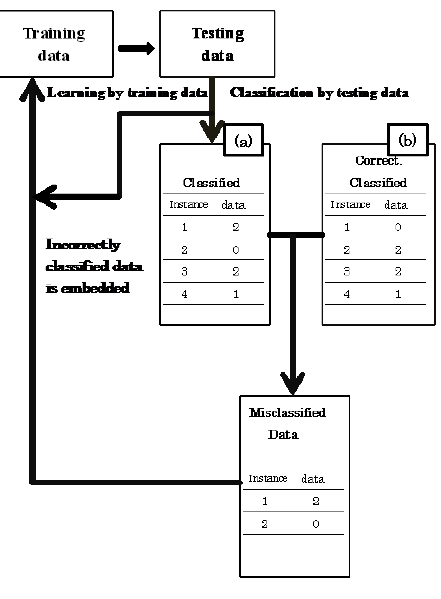
Fig. 10. An embedding computation strategy